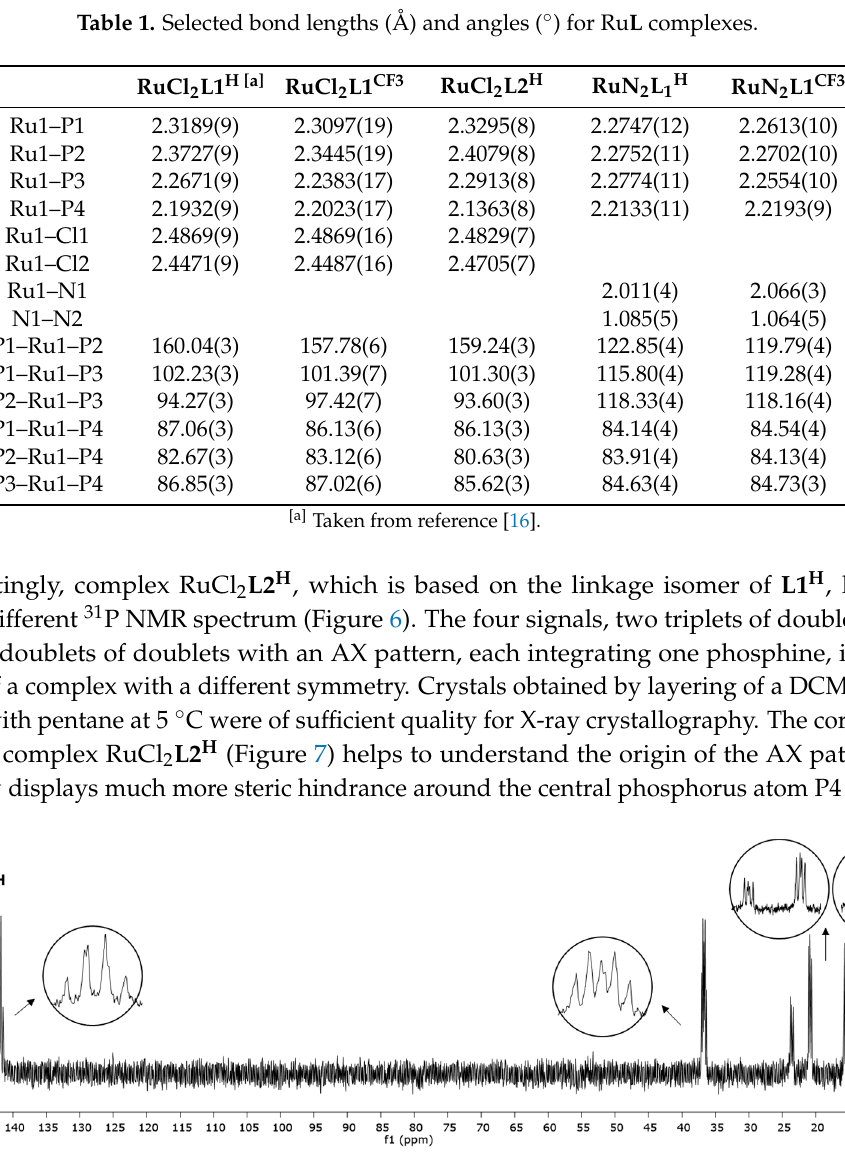
Table 1. Selected bond lengths (Å) and angles (°) for Ru L complexes.